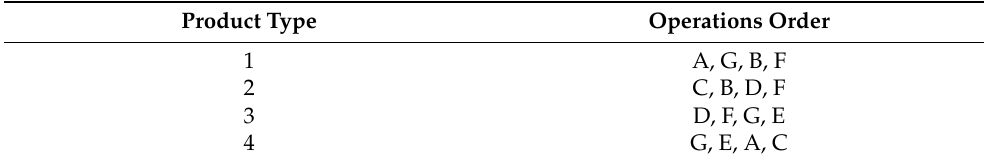
Table 1. Definition of order operations for coming parts.